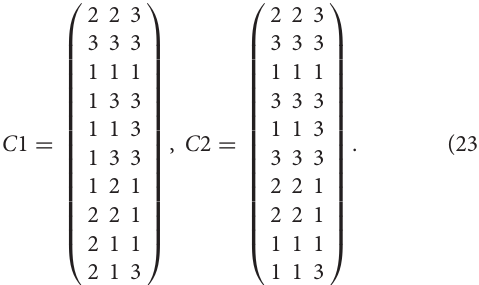
FIGURE 2 | Paradigm used for fMRI experiment. The checkerboards were showed at the high bar period and hid at the low bar period